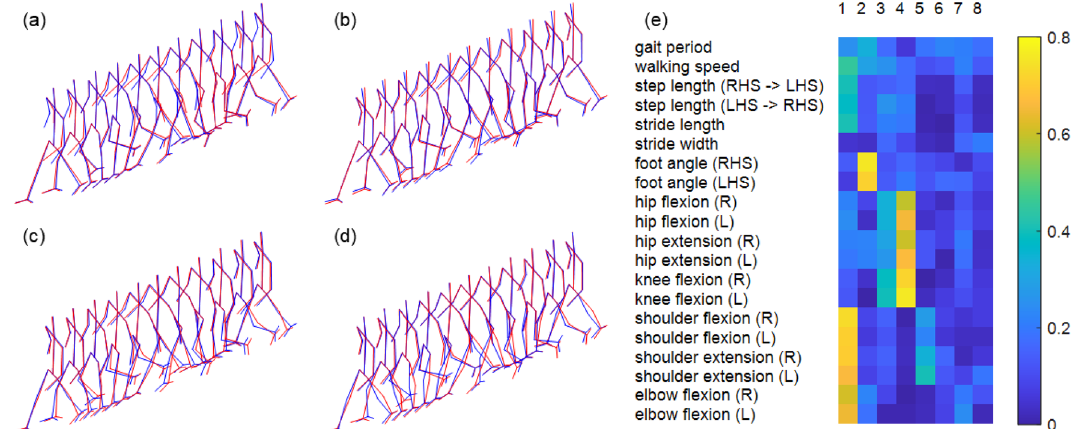
Figure 3. (a–d) Effect of the first four principal components were visualized by motion varying scores corresponding to each principal component. Each figure is about the first (a) , second (b) , third (c) , and fourth (d) principal component. The motion represented with red and the blue lines indicate the gait reconstructed by adding and subtracting the principal component from the mean gait. (e) Correlation of the principal components and clinical gait parameters was shown as a